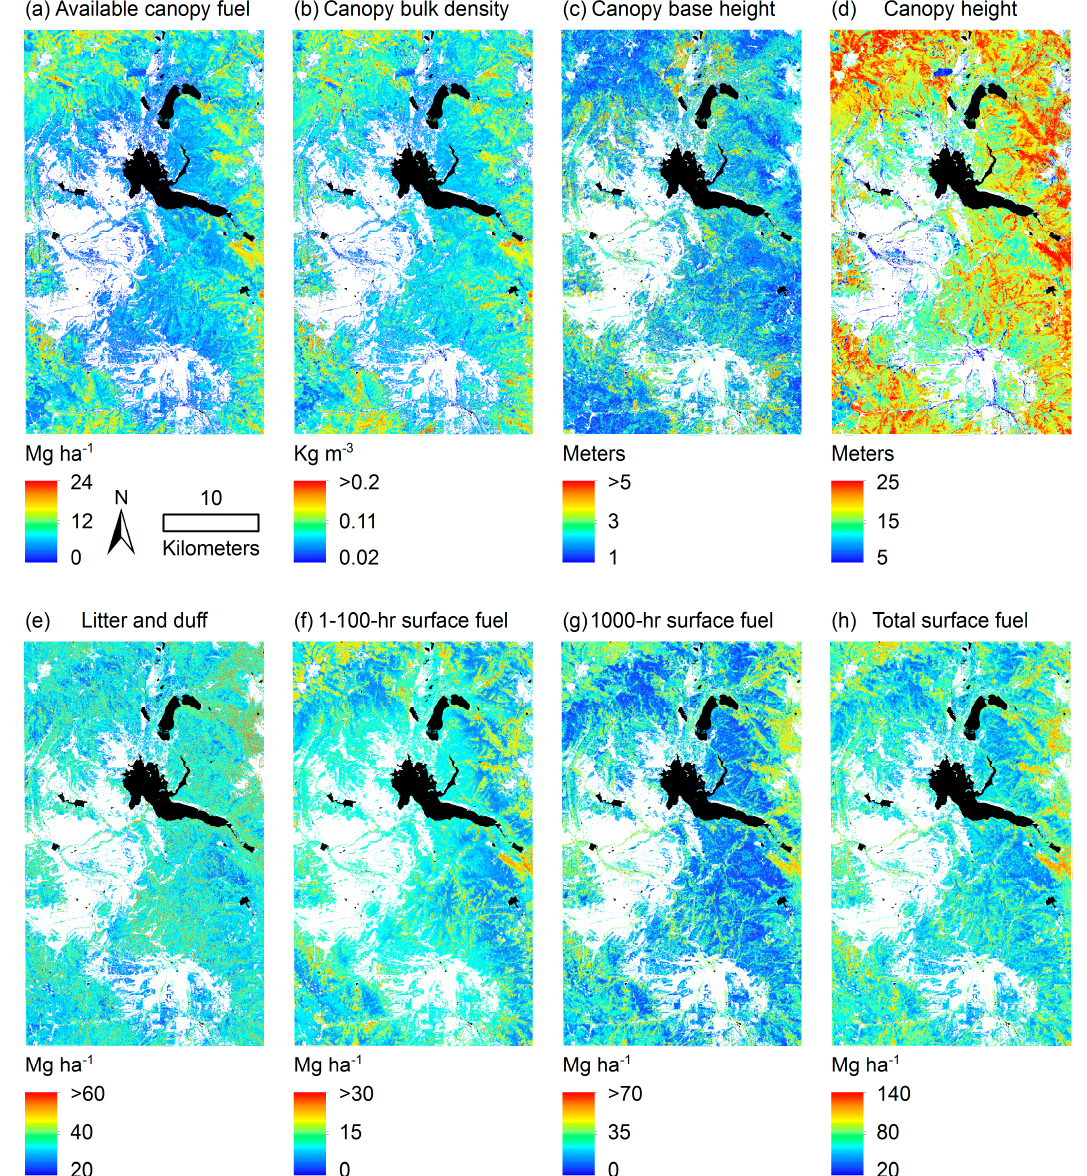
Figure 5. Maps of predicted canopy ( a – d ) and surface fuel variables ( e – h ) across the study area. Areas where canopy cover is <10% are masked in white. Water bodies are black. Maps were created by applying random forest models to explanatory variable grids.